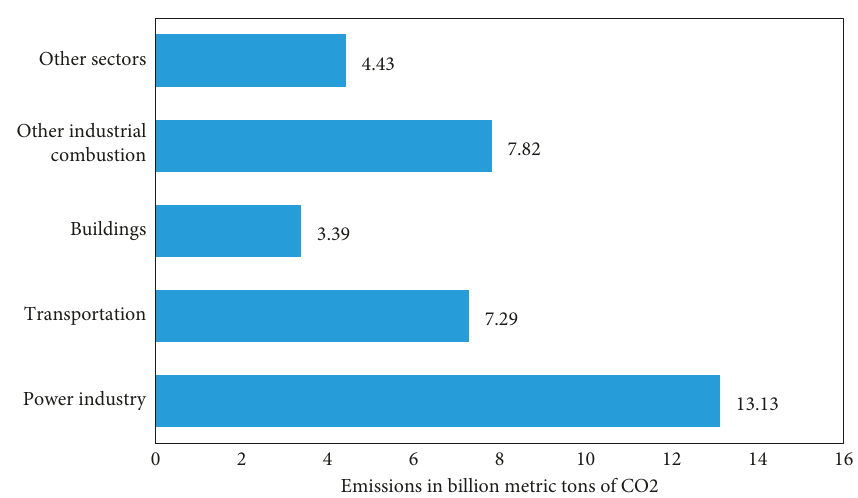
Figure 2: Global carbon emissions by sector in